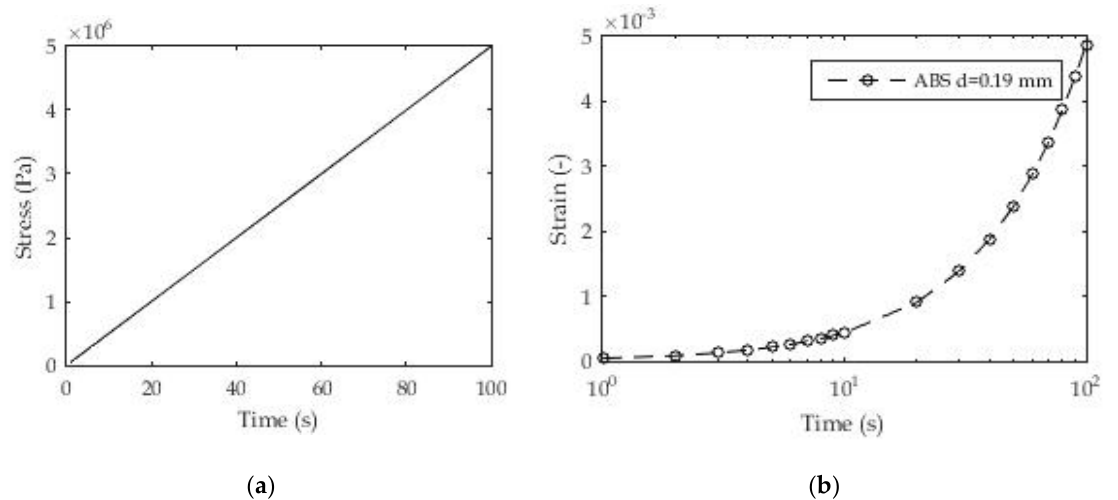
Figure 8. ( a ) Constant stress-rate test; ( b ) experimental results for strain ε (t).